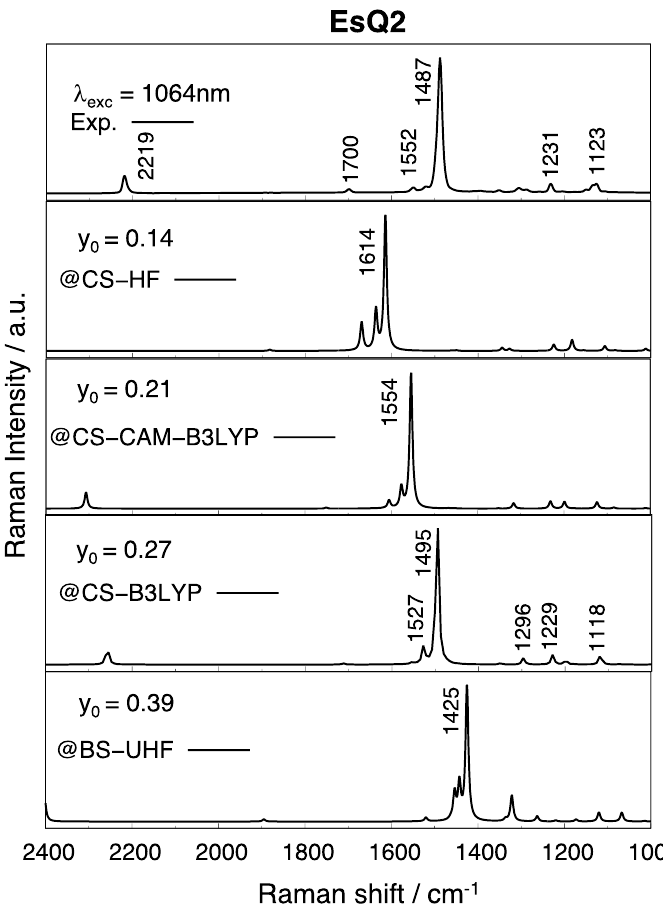
Figure 6. Comparison between experimental (top, spectrum measured at 1064 nm) and computed Raman spectra for the library of ground state geometries of EsQ2 characterized by increasing diradical character as indicated in the top left part of each panel. Table 3. Computed HR factors for the optically active transition of EsQ2, EsQ3 and EsQ4